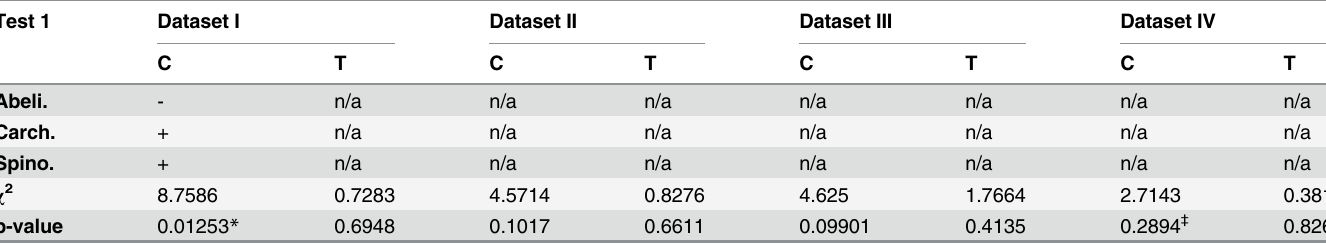
Table 2. Results of Chi-square Test 1 as presented by software R.